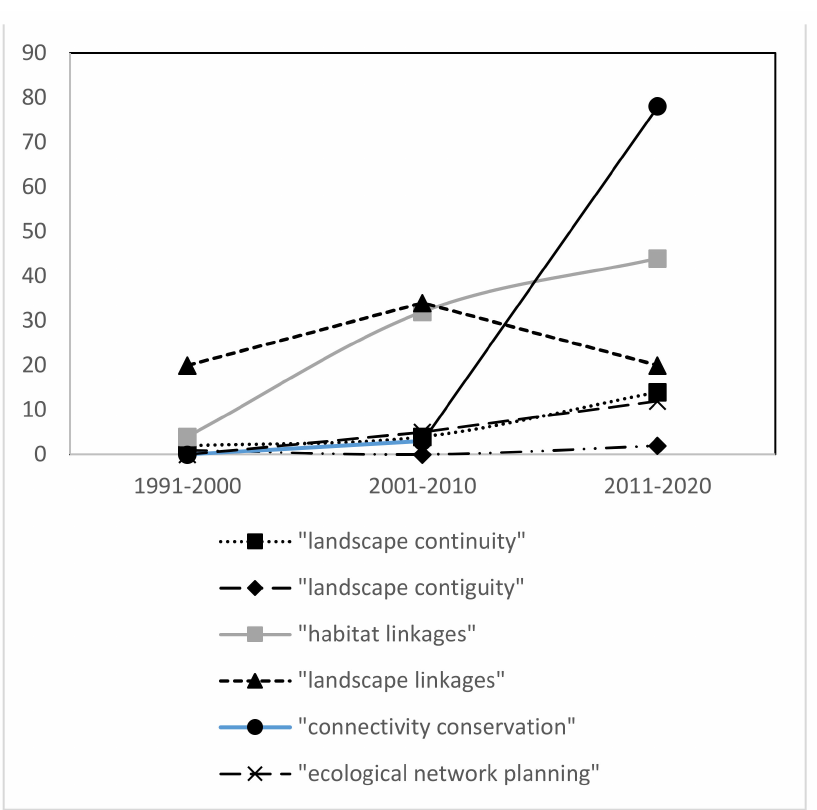
Figure 4. Secondary key terms in the habitat fragmentation disciplinary arena. Trends in number of recurrences ( y -axis) from 1991 to 2020.